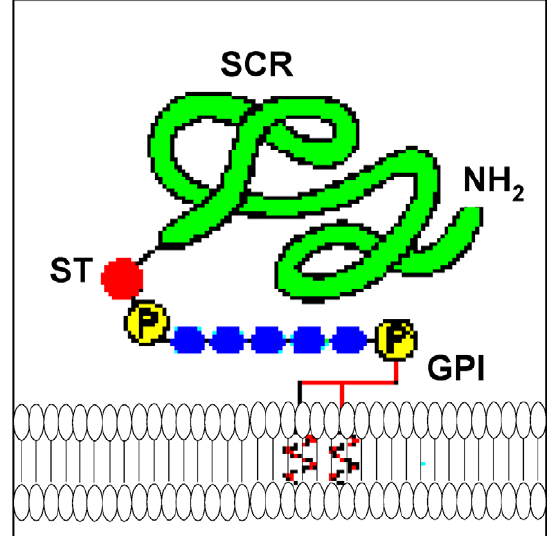
Fig. 1. Schematic representation of the structure of DAF. SCRs, short consensus repeats; GPI, glycosyl phosphatidyl inositol membrane anchor; ST, serine/threonine-enriched domain capable of extensive O -linked